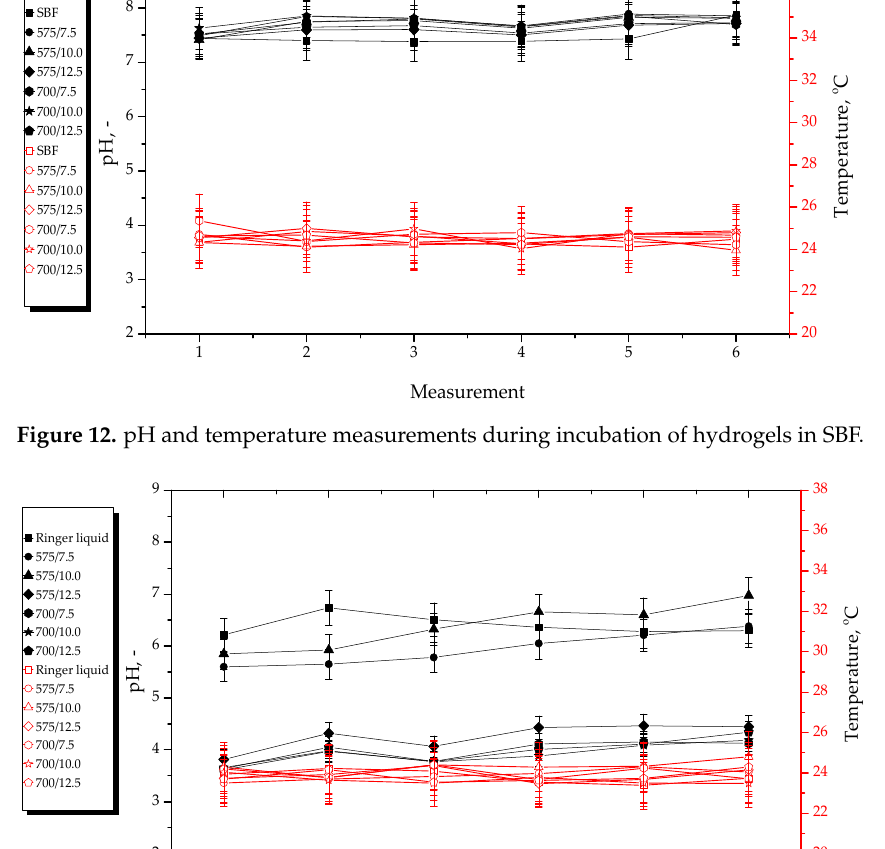
Figure 13. pH and temperature measurements during incubation of hydrogels in Ringer liquid.